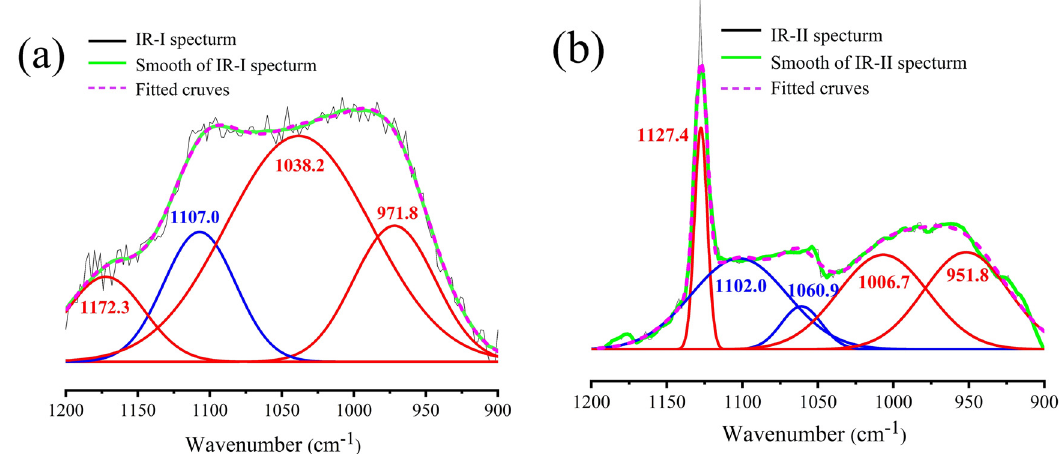
Figure 6: AFM - IR spectra collected at positions ( a ) IR - I and ( b ) IR - II along with the results of band